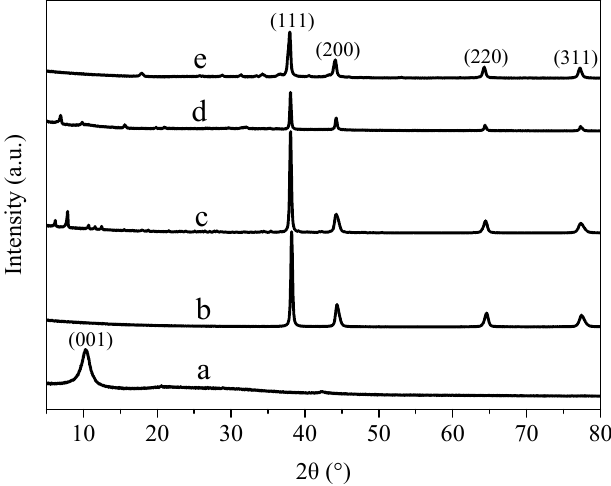
Figure 2. XRD patterns of the samples: ( a ) GO; ( b ) AgNWs; ( c ) NH 2 -AgNWs; ( d ) AgNWs/GO-1 and ( e ) AgNWs/GNs-1.